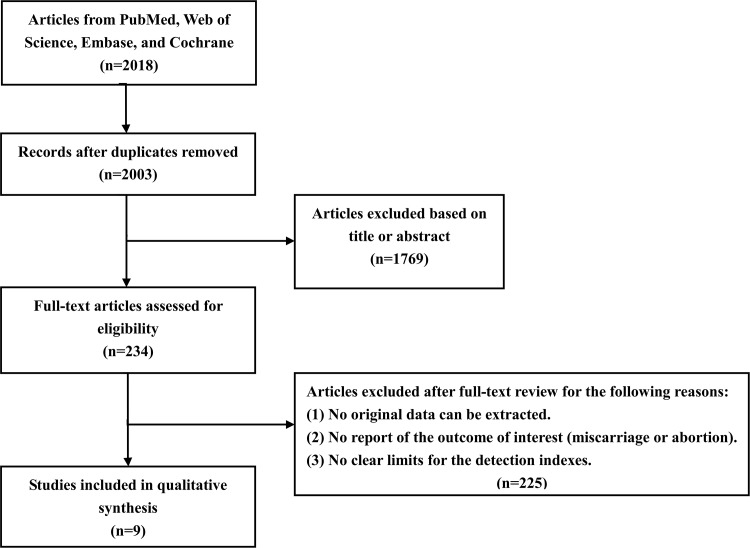
Flow diagram of the literature search.